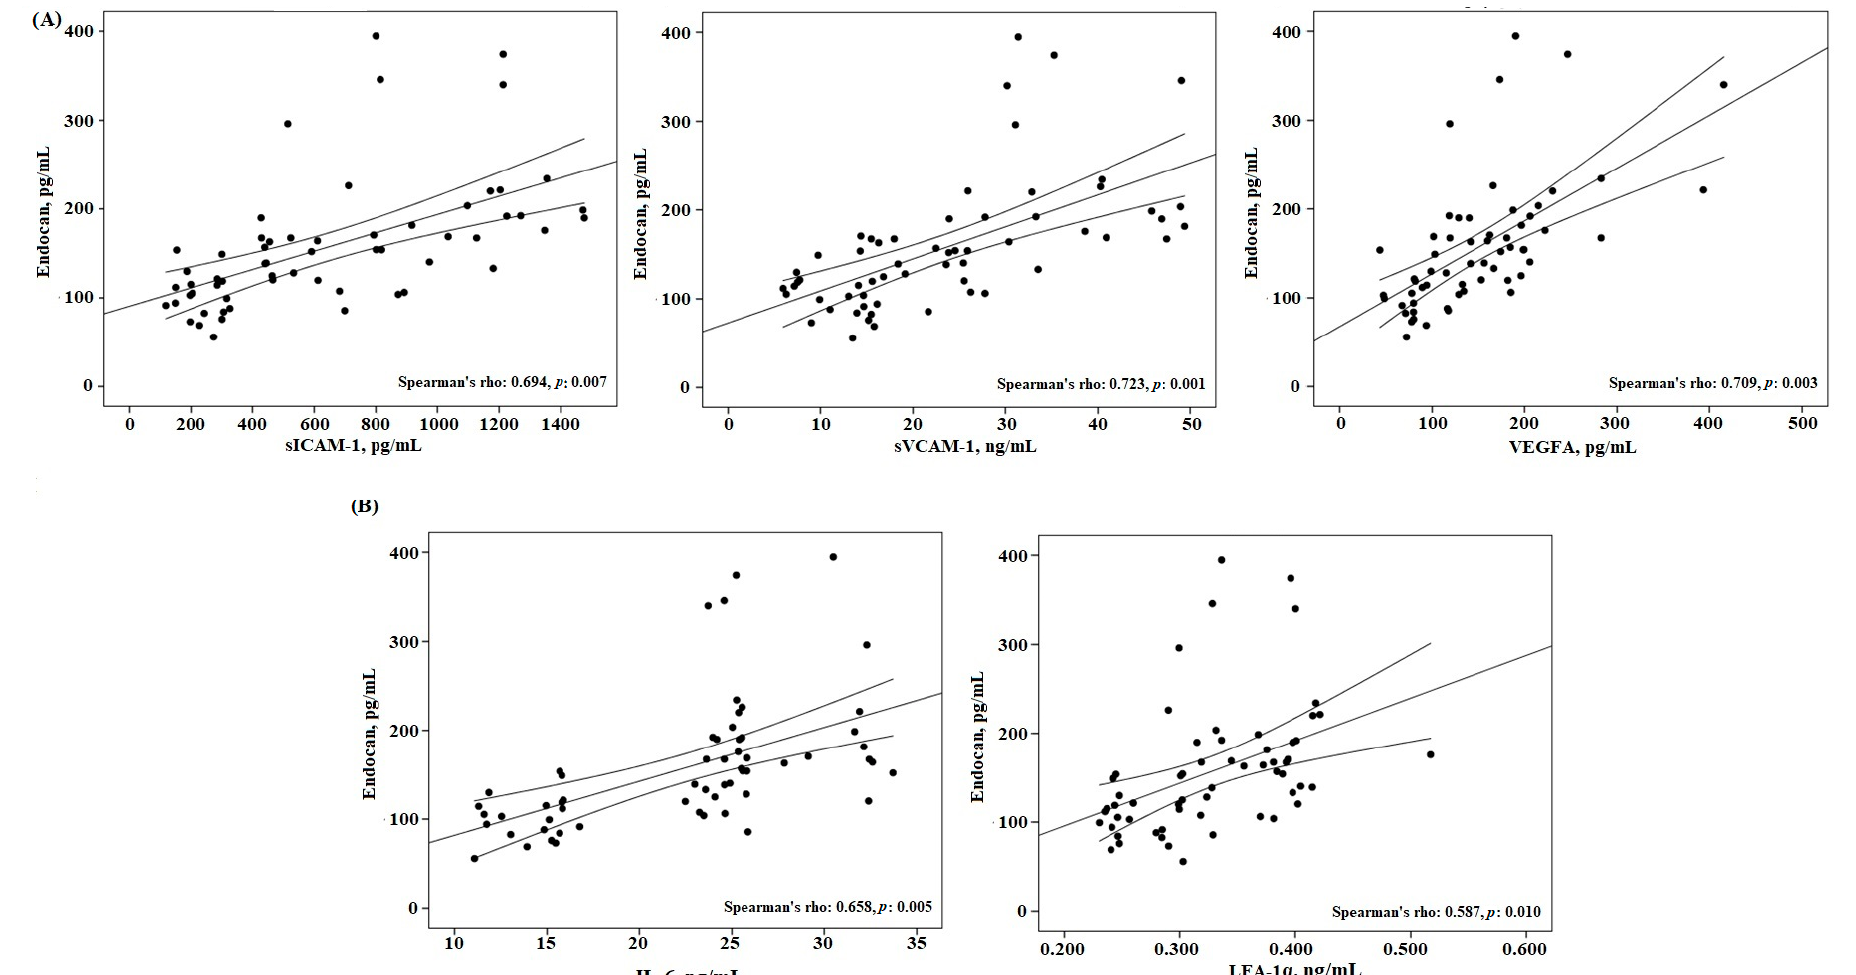
Figure 2. The correlation between ( A ) endocan and endothelial factors and ( B ) endocan and inflammatory factors in PPL group.